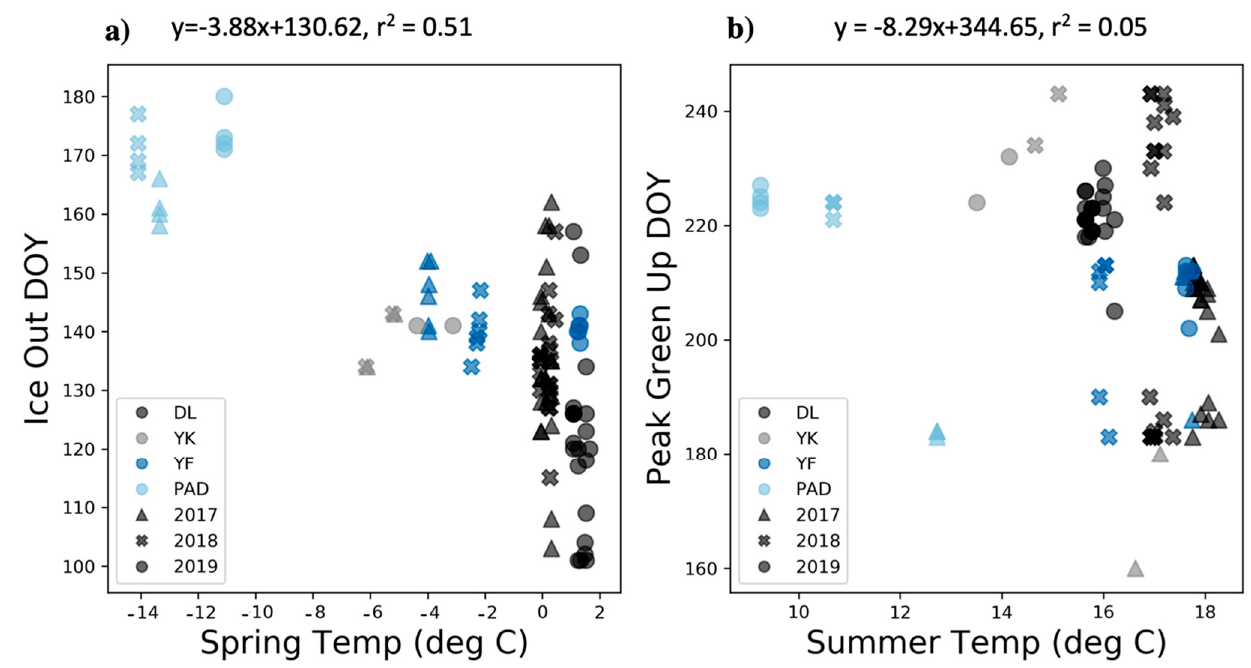
Figure 7. Ice-out day-of-year relative to spring temperature ( a ) and peak green day-of-year relative to summer temperatures ( b ).